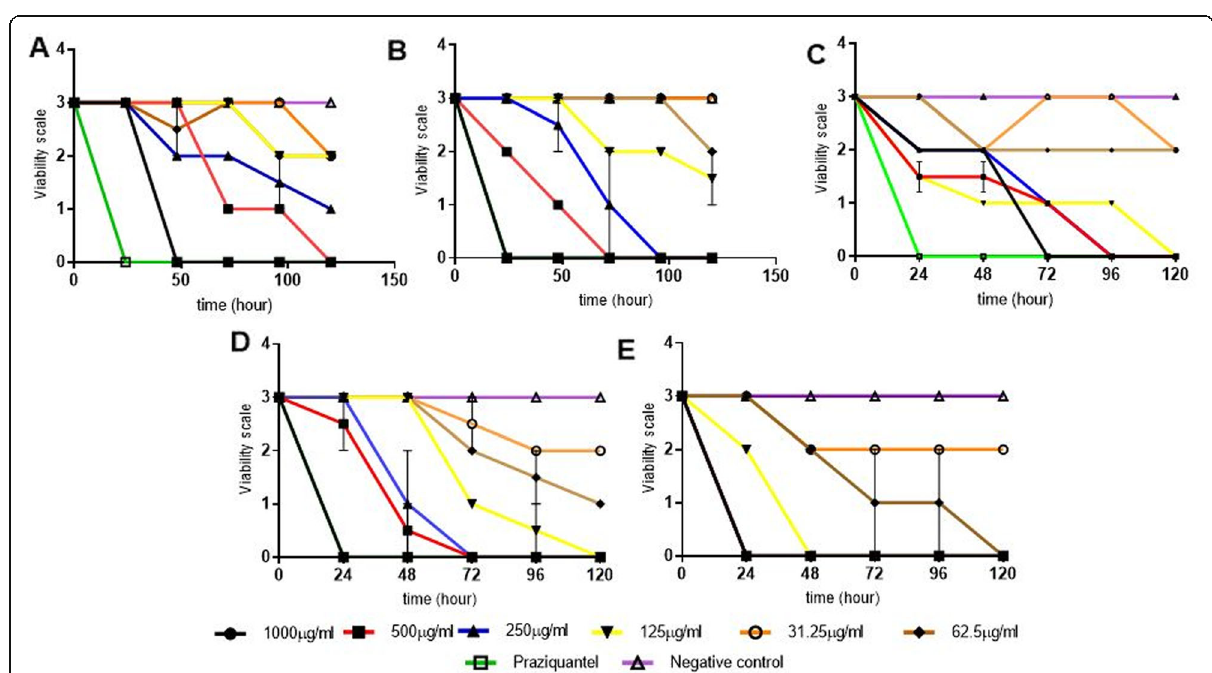
Fig. 2 Anti-schistosomal activity of extracts. The percent mortality rate of the adult worm after N. latifolia ( a ), V. amygdalina ( b ), M. lucida ( c ), P. amarus ( d ) and A. indica ( e ) treatment. There was however no statistical difference between A. indica and PZQ